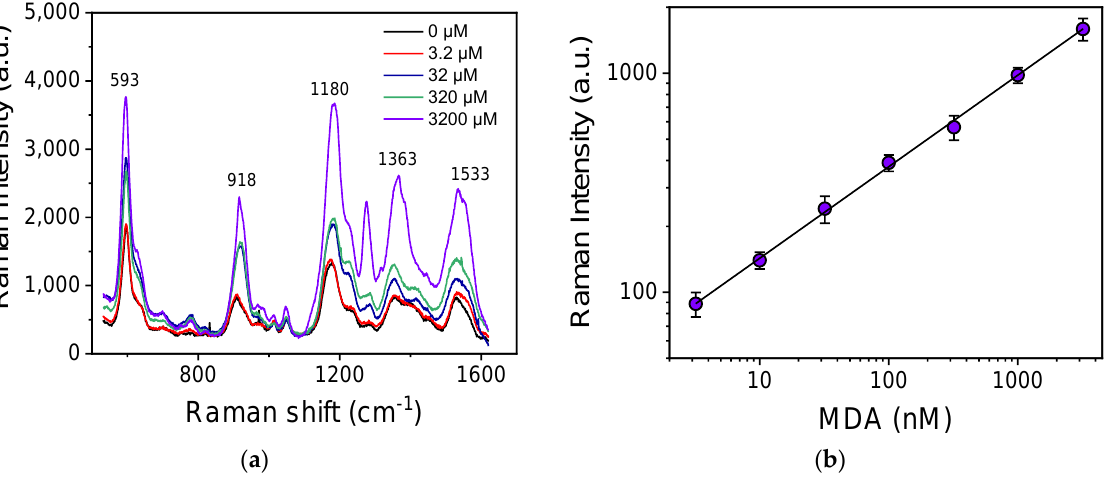
Figure 6. ( a ) SERS spectra of TBA-MDA derivative for MDA concentrations ranging from 0 to 3200 nM. ( b ) Calibration curve of MDA. Each point corresponds to measurements received from 5 substrates (3 different spots per substrate) ± SD.